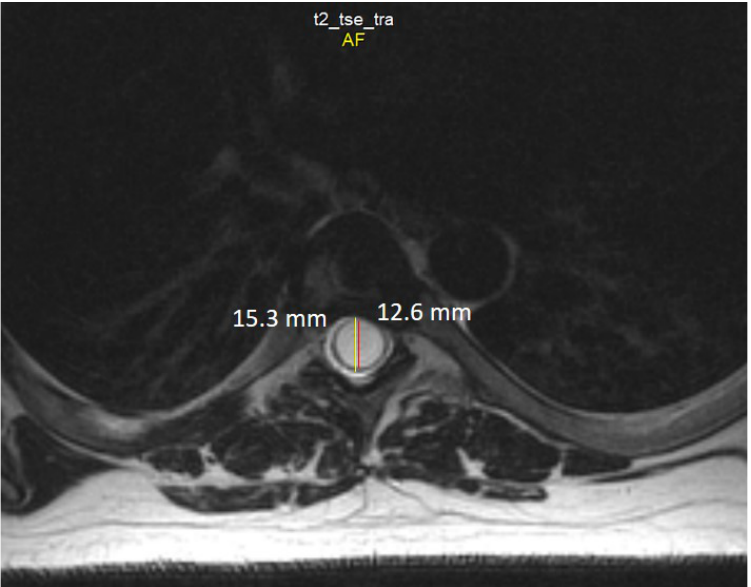
Figure 6. Axial T2-weighted MRI scan of the thoracic spine demonstrates the anteroposterior dilation of the syrinx (red line) and spinal cord (yellow line) at the level of the Th6 vertebra. In addition to changes in the structure of the spinal cord, coronal sections revealed signs of moderate curve ‘S’-shaped scoliosis. In the thoracic region, the scoliotic curve bends to the left by 27 degrees, and in the cervical region, the scoliotic curve bends to the right by 20 degrees (Figure 7), which is a characteristic feature for Syr. As we know, the development of scoliosis in such patients may be associated with denervation of the paraspinal muscles